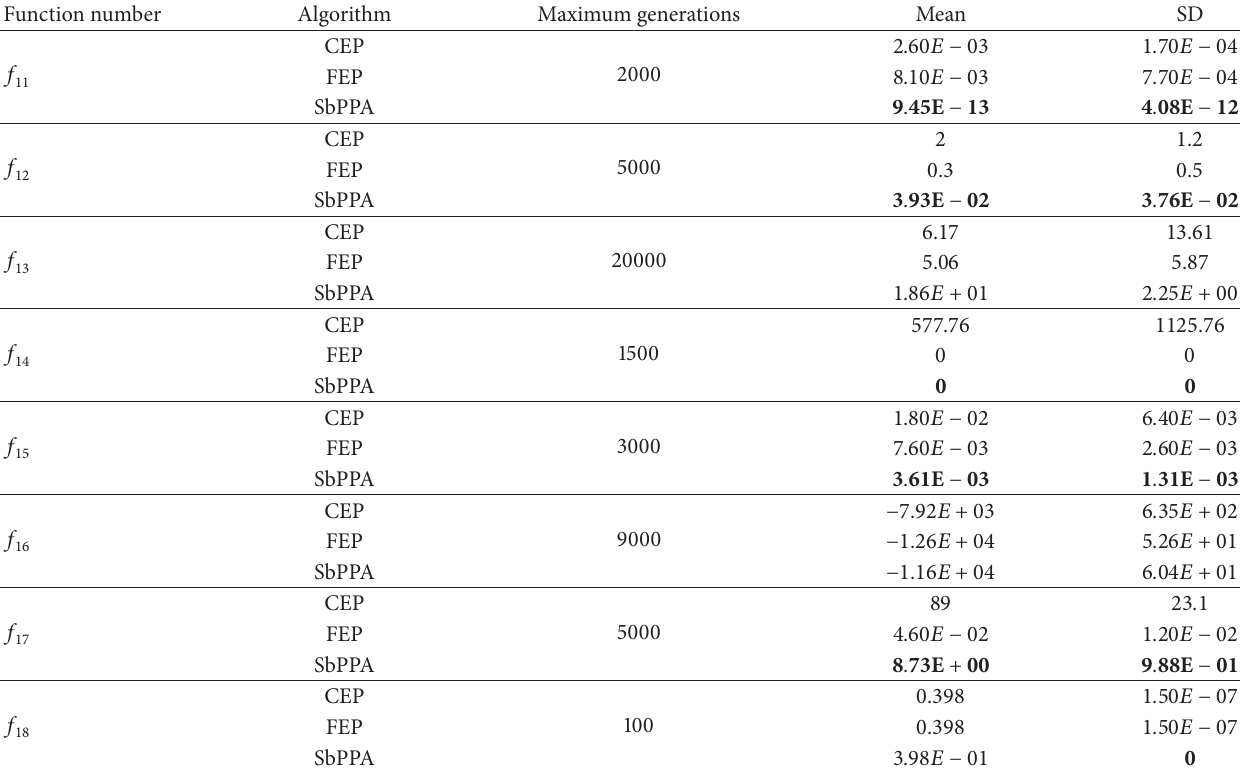
Table 5: Results obtained by SbPPA, CEP, and FEP. All problems in this table are unconstrained [30]. Function number